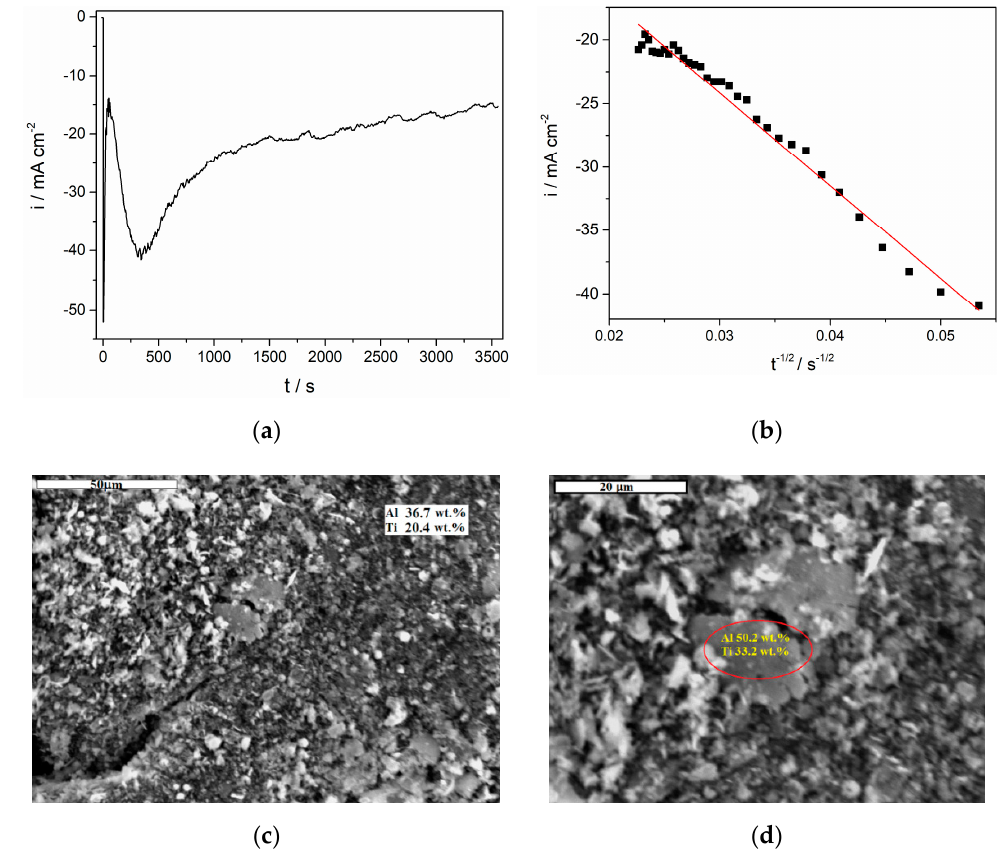
Figure 7. Potentiostatic deposition on the GC working electrode from the equimolar AlCl 3 -NaCl melt containing anodically dissolved Ti at − 0.085 V and 200 °C for two hours: ( a ) current–time transient of the deposition; ( b ) current as a function of t − 1/2 for the falling part of the transient in (a); ( c , d ) SEM photographs of the deposit obtained with energy-dispersive spectroscopy (EDS) results embedded.